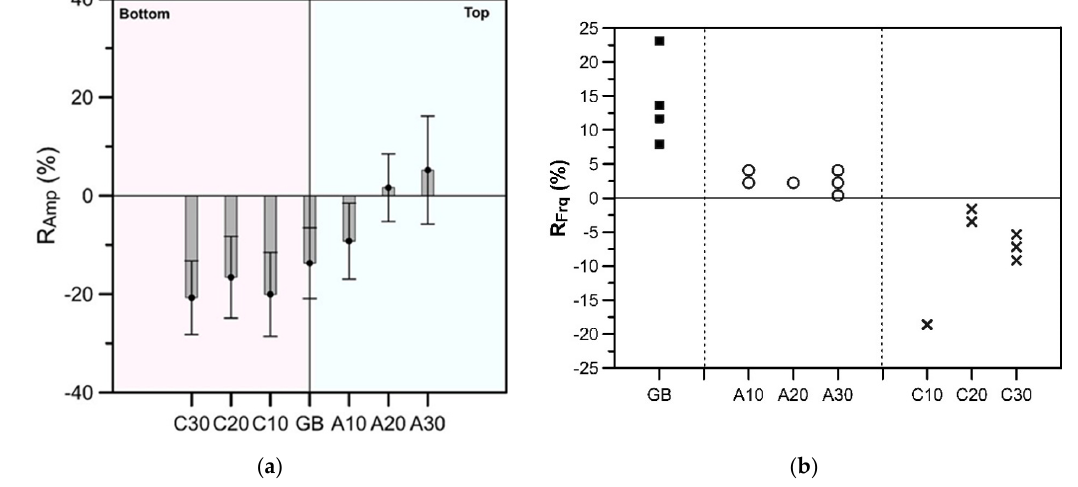
Figure 9. Variation of ( a ) R amp and ( b ) R frq for the flawed and the good adhesion cases. A parameter, AF ‐ index, is proposed to assess defects more accurately and quickly within 36 mm CA mortar layer without knowing the position of the defect. The AF ‐ index is defined by the multiplication of R frq and R amp , as shown in Equation (8). Figure 10 shows the relationship between the AF ‐ index and the lateral dimension of defects regardless of the location of the defect within the CA mortar layer. For the good adhesion cases, the AF ‐ indices are mostly below − 50. For defects on the top of the CA layer, the AF ‐ indices are mostly between − 50 and +50. For the defects on the bottom CA layer, the AF ‐ indices are mostly larger than 50 and decrease with the increase of the lateral dimension. Notice that. as the defect of C20 is floated from the bottom, the AF ‐ index are close to the ones of A20. Thus, it is reasonable to conclude that a defect with the lateral size larger than 0.1 m may be presented within the CA layer when the AF ‐ index is larger than − 50.